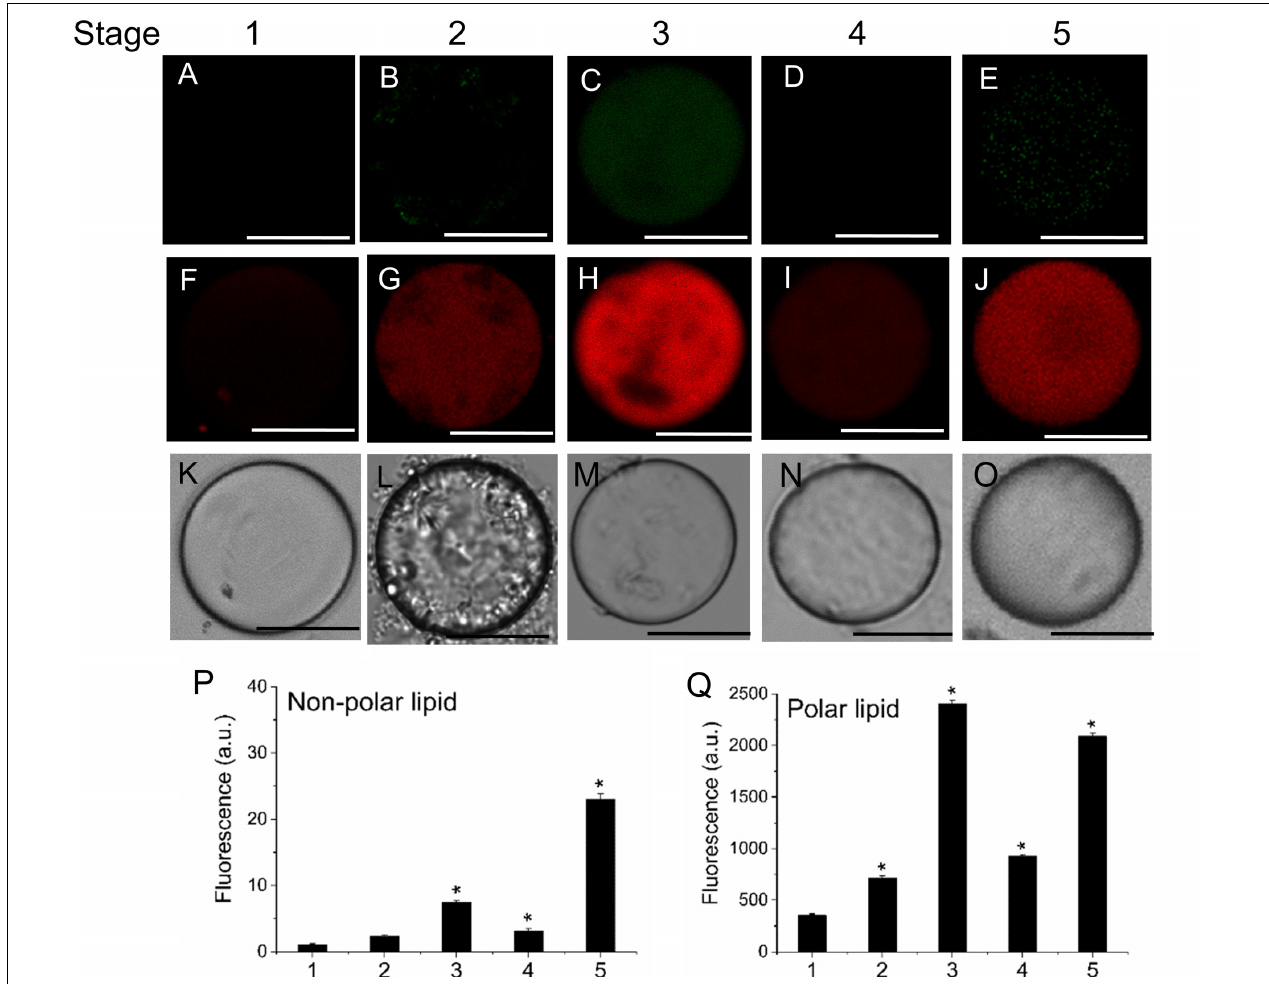
FIGURE 3 | Distribution of non-polar and polar lipids of live protoplasts from olive fruit during development. Fluorescence of variable color from protoplasts indicated a difference in neutral lipid composition: neutral or non-polar lipid appeared as green (A–E) and polar lipid appeared as red (F–J) . (A–J) Nile Red stained protoplasts from the olive fruit at different stages of development compared to the white-light image K–O ). Scale bars are 10 µ m. (P,Q) Quantification of Nile Red fluorescence in live protoplasts from olive fruit at different stages of development. The orange/red fluorescence of Nile Red was acquired with a 630 nm long-pass filter, and the mean fluorescence intensities of olive-fruit protoplasts were measured in a logarithmic scale. Data from about 20 protoplasts were acquired per sample, and data were compiled using FV10 4.2 software (Olympus). Columns and bars indicate means ± SD, respectively, from five independent experiments. Statistically significant differences from the preceding point based on unpaired Student’s t -test at P < 0.05 are denoted by